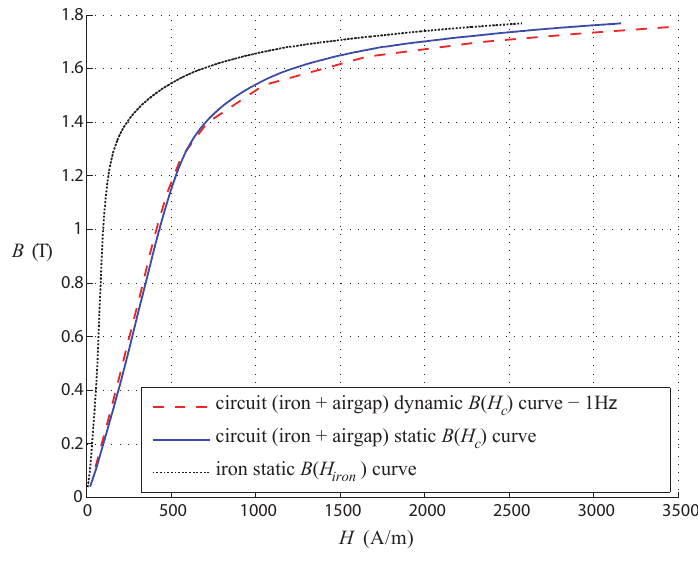
Figure 9. Static and dynamic characterizations of the